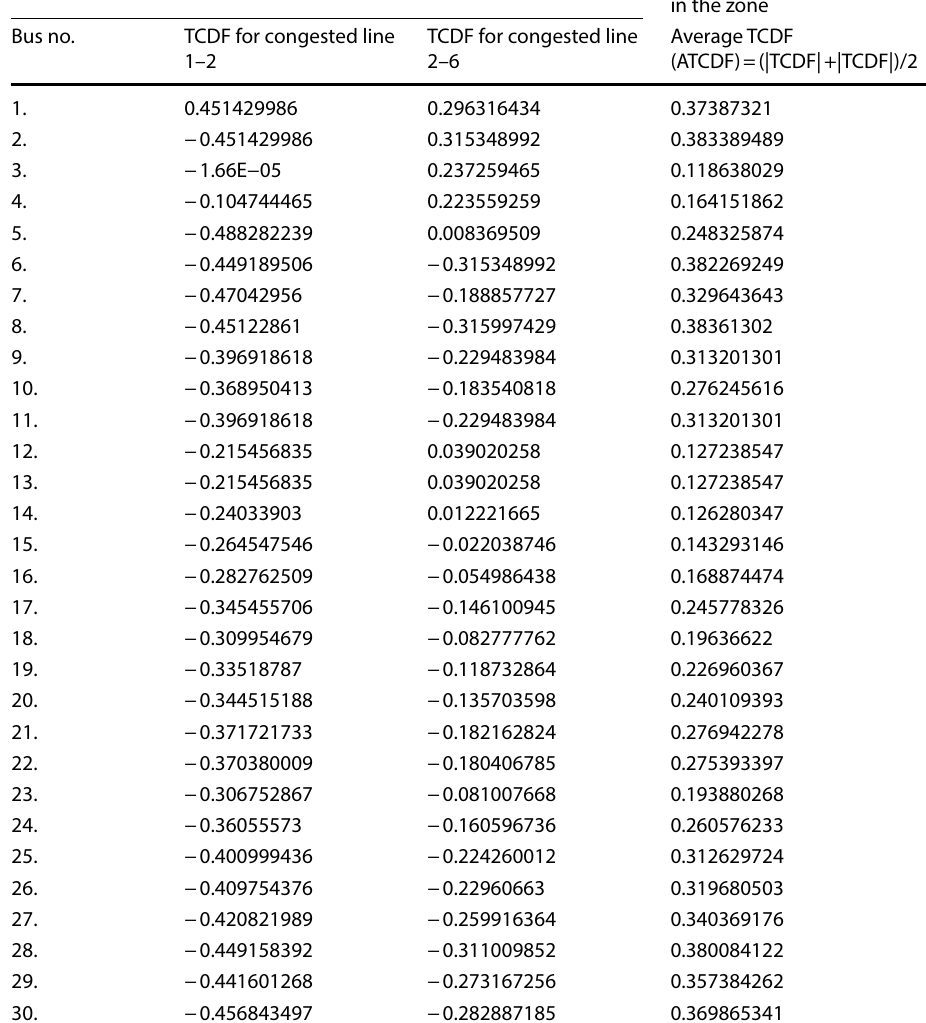
Table 2 ATCDF value for different buses